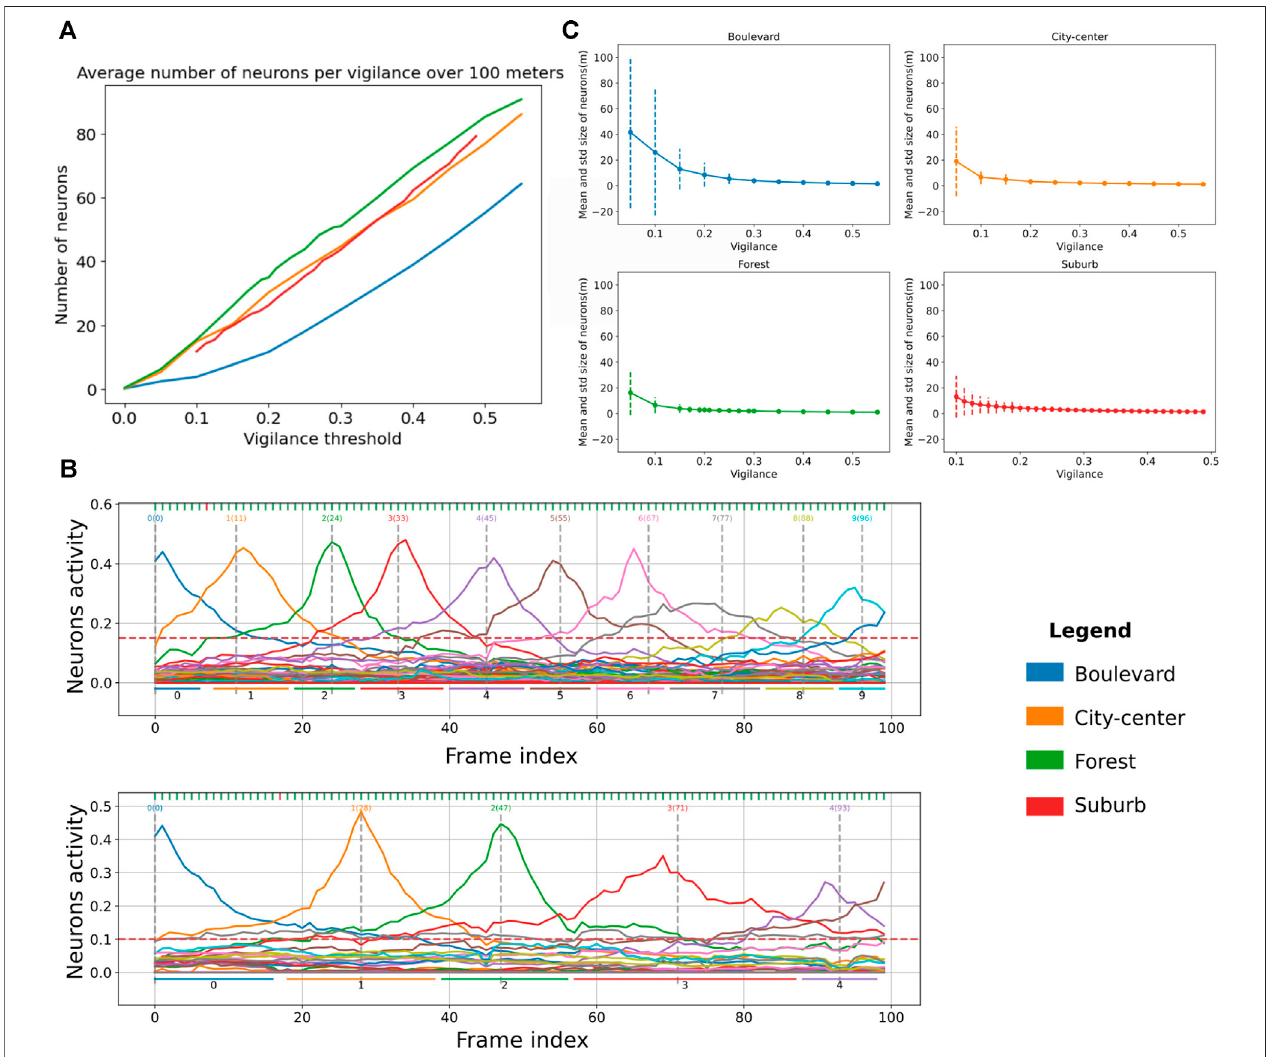
FIGURE9| Evaluation graphsofLog-PolarMax-Pi (LPMP)+ Vig dynamics. (A) Evaluationofthe number ofneuronscreatedbythe LPMP +Vig model over 100 m according to the vigilance threshold and the environment. (B) Illustration of the activities of the spatial neurons of the LPMP model during a navigation sequence. Each vertical gray line corresponds to the index of the frame at which the learning of a spatial neuron occurs. The horizontal lines correspond to an estimate of the space encoded byneuron. The fi rst graph has a vigilance of 0.25 and the second of 0.15. (C) Evaluation ofthe average size of spaces encoded by LPMP spatial neurons as a function of the vigilance. The dotted lines represent the standard deviation around the mean